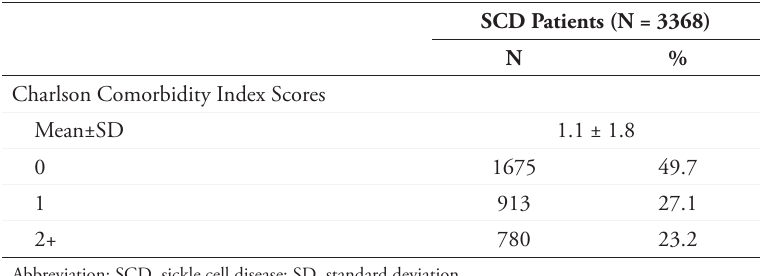
Table 1. Baseline Characteristics for Patients with SCD (N = 3368) ,